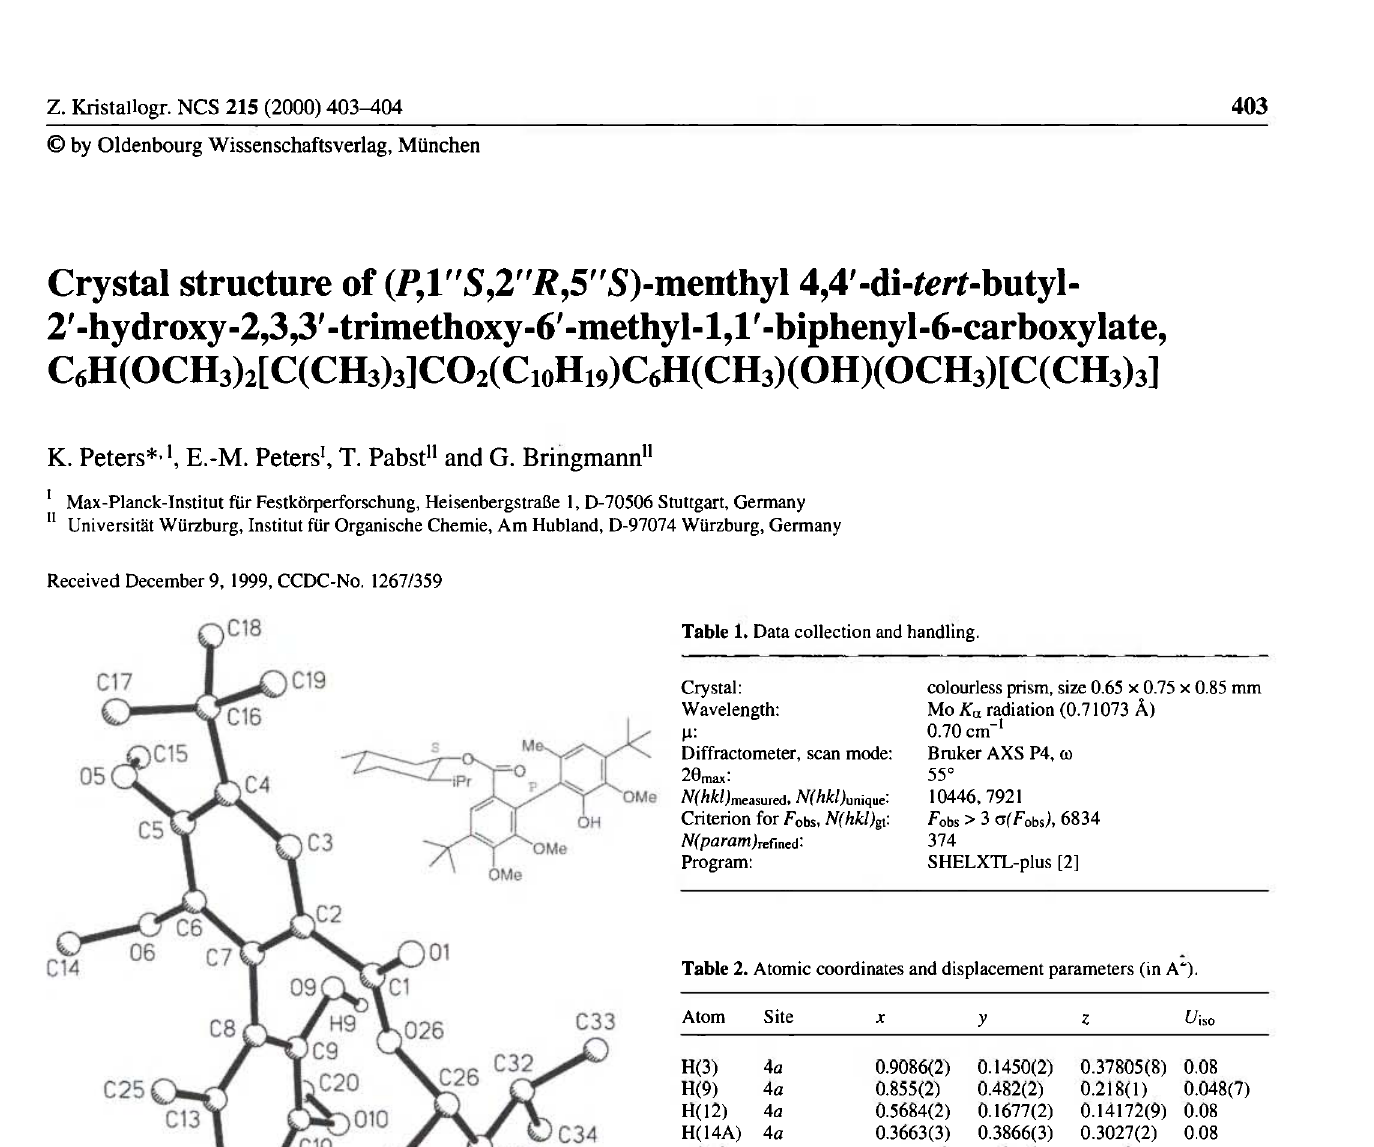
Table 2. Atomic coordinates and displacement parameters (in A